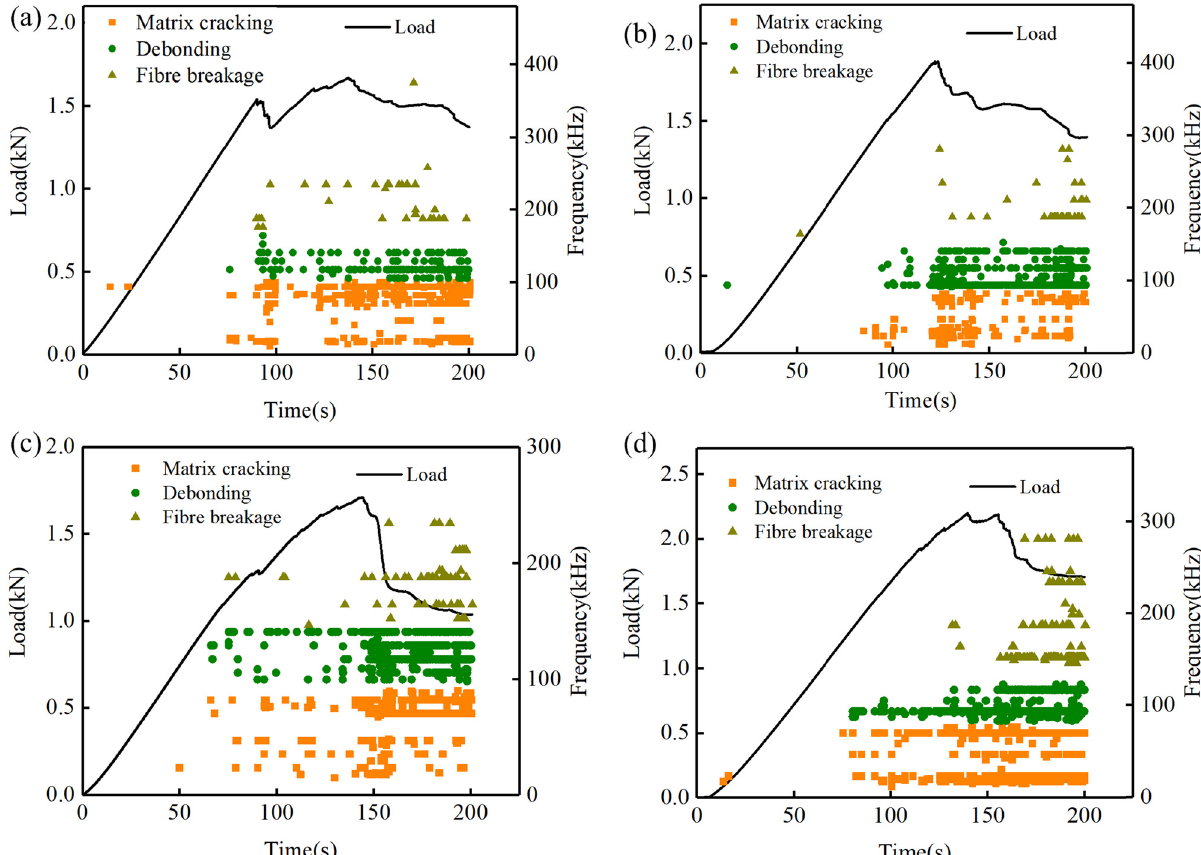
Figure 8: Load and frequency of di ff erent specimens versus time: ( a ) – ( d ) Specimens A –